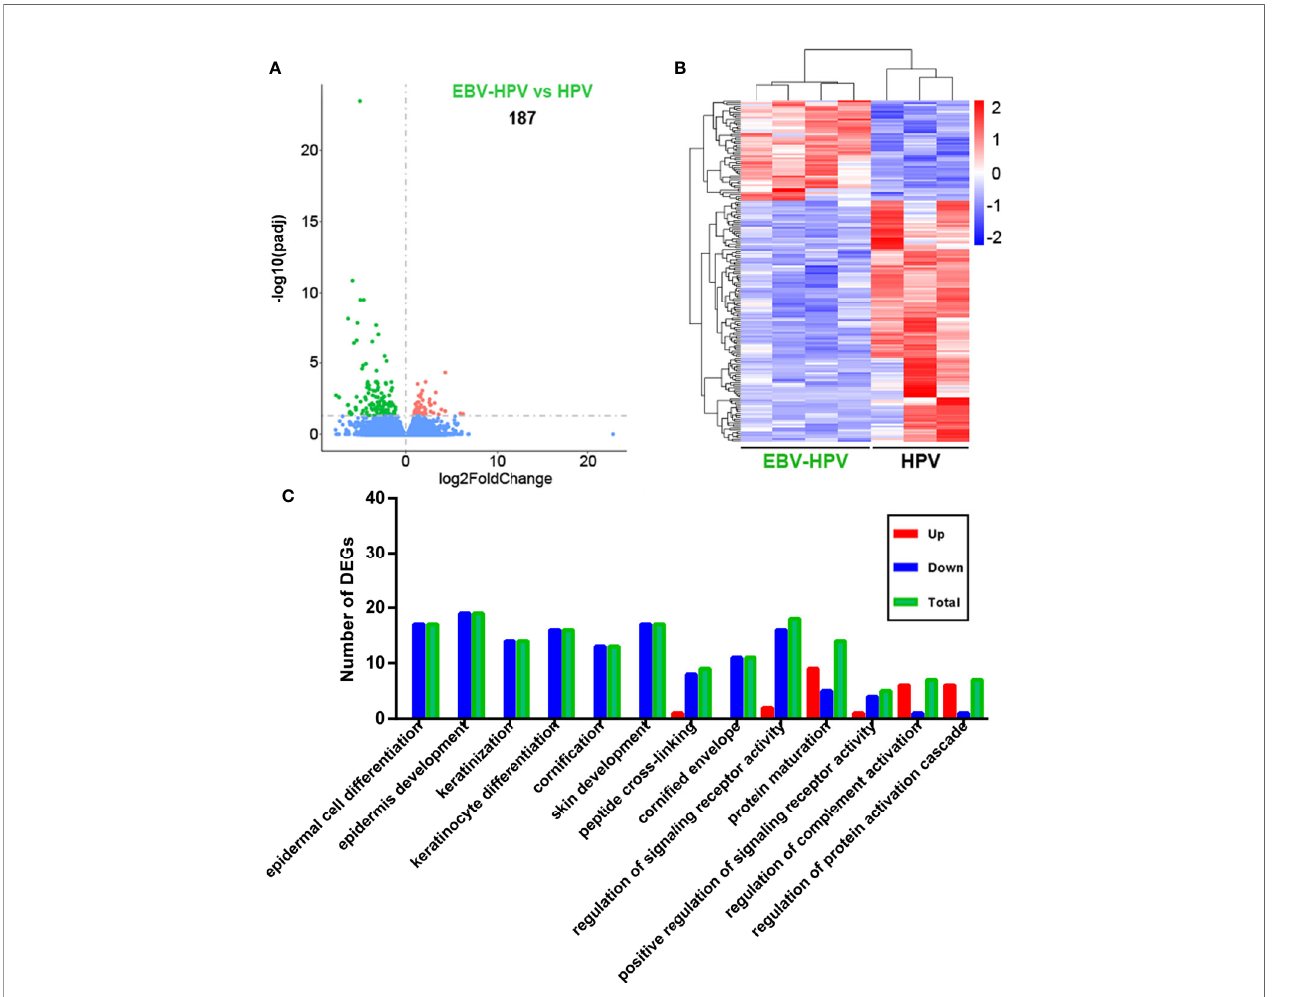
FIGURE 3 | Analysis of cervical tissue transcriptome data of different viral infection statuses. (A) Differences in gene expression in the EBV and HPV coinfection groups compared with the HPV infection alone group (red and green dots indicate DEGs); the numbers in plots indicate the numbers of DEGs. (B) Hierarchical cluster analysis of DEGs within different paired comparisons con fi rming that patients with each infection or coinfection status could be grouped together based on similar gene expression pro fi les (red, upregulated; blue, downregulated). (C) Numbers of DEGs belonging to numerous signi fi cantly altered GO enrichment terms (up, upregulated DEGs; down, downregulated DEGs; total, total